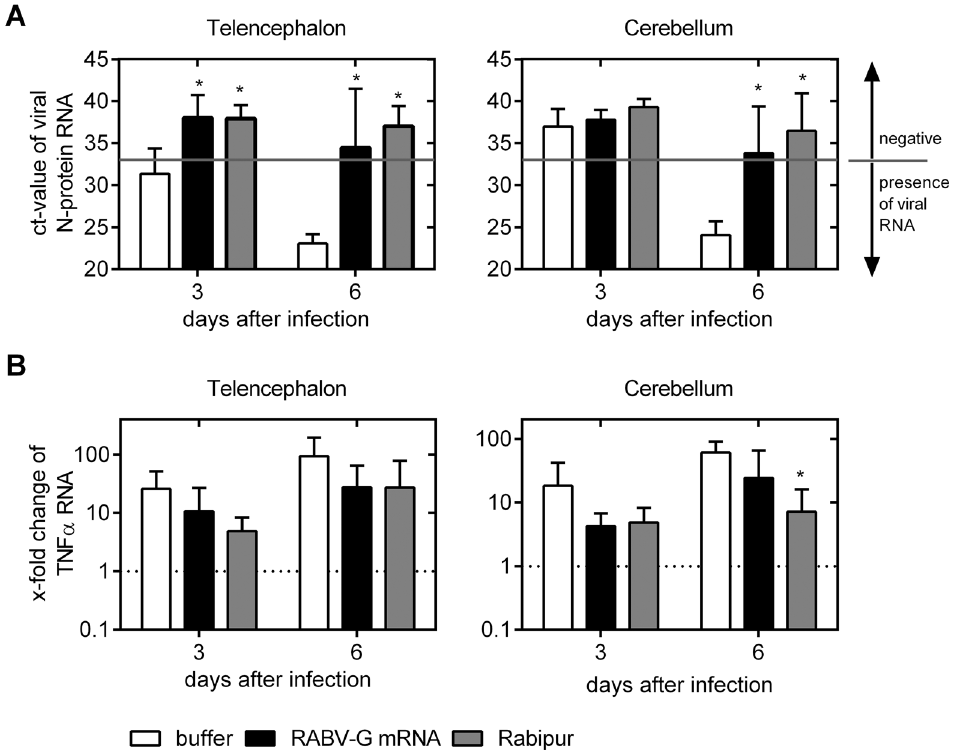
Fig 4. qRT-PCR analysis of viral N-protein encoding RNA and cellular TNF α mRNA transcript levels in brains 3 and 6 days after i.c. rabies challenge infection. Female BALB/c mice were injected with buffer alone ( white bar ), 80 μ g RABV-G mRNA ( black bar ) or 0.1 human dose Rabipur ( grey bar ), on study days 0 and 21. 5 weeks after second immunization, mice were i.c. infected (into the telencephalon) with rabies virus.